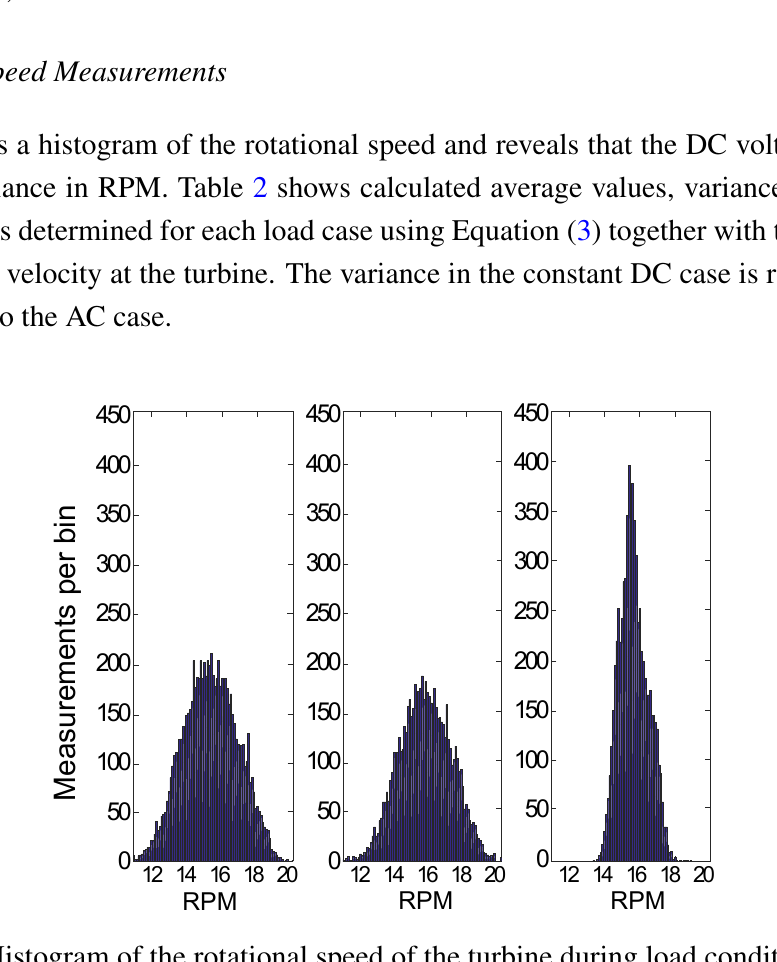
Figure 9. Histogram of the rotational speed of the turbine during load conditions. From left to right: AC load, fixed PWM and constant DC. Table 2. Rotational speed of the turbine and the number of measurements of the three load cases. Calculated average λ from the average water speed and average